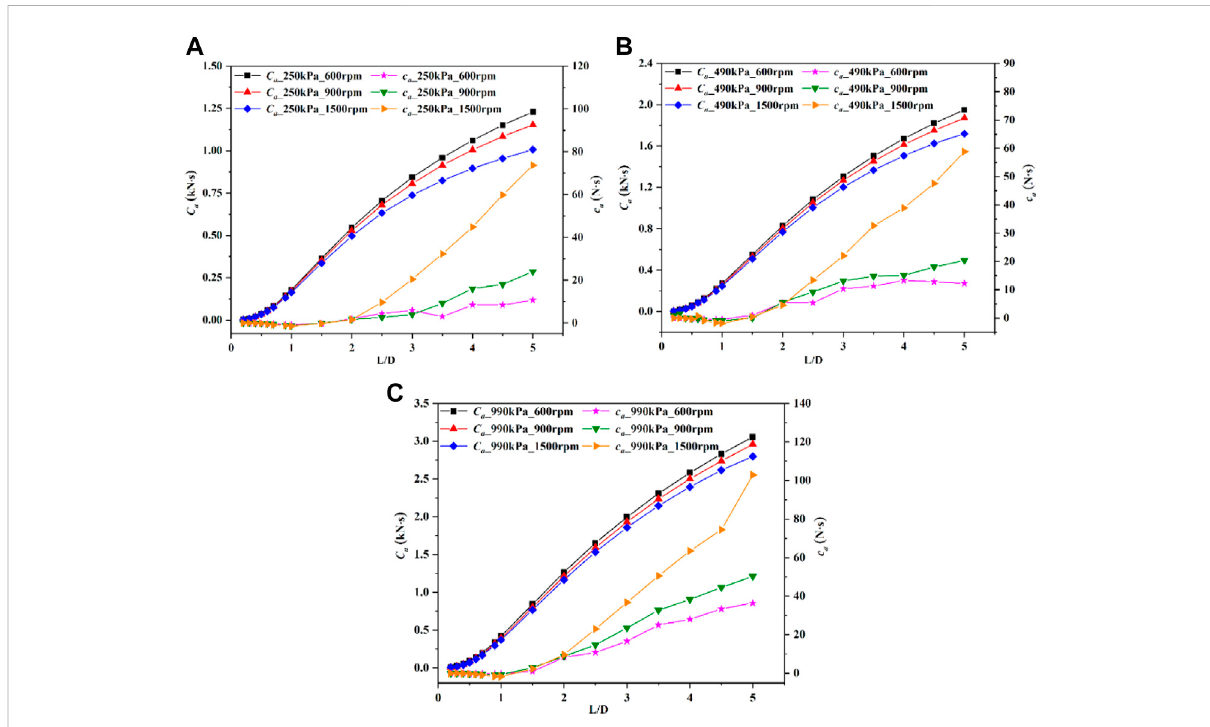
FIGURE 8 The variations of damping coef fi cients with length-diameter ratio under different pressure differences and rotational speeds. (A) 250 kPa. (B) 490 kPa. (C) 990